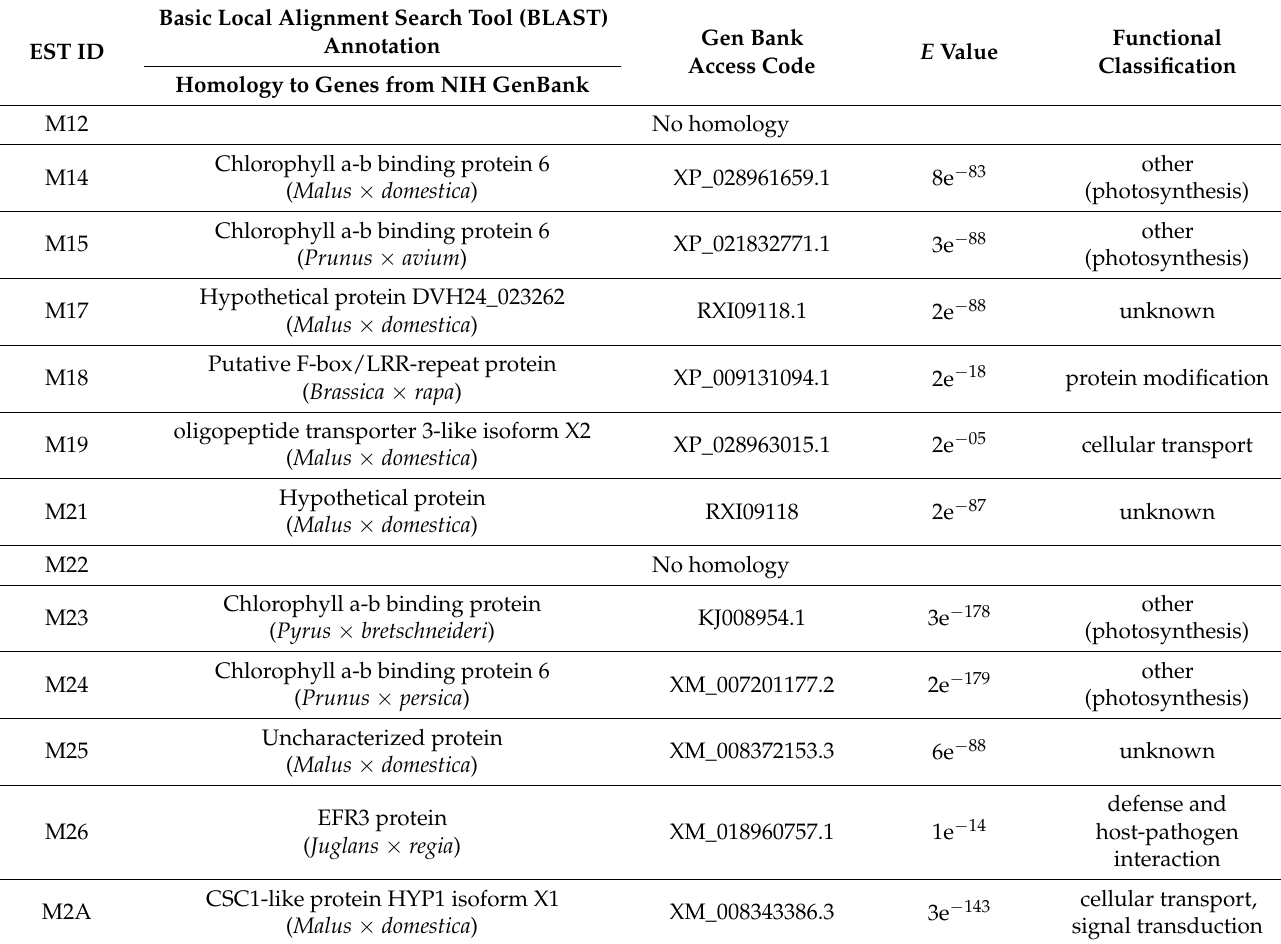
Figure 8. cDNA-AFLP analysis for three ‘Free Redstar’ apple tetraploid clones 4x-1, 4x-2, and 4x-3 compared to their diploid (2x) counterpart during V. inaequalis infection. Table 4. Homology and functional classification of upregulated dESTs during V. inaequalis infection of ‘Free Redstar’ tetraploid genotypes.